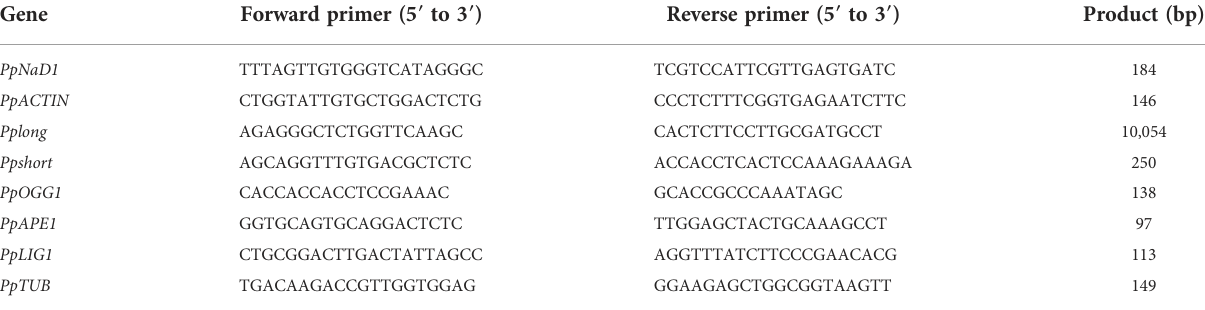
TABLE 1 DNA primers used for real-time PCR and long PCR. Gene Forward primer (5 ′ to 3 ′